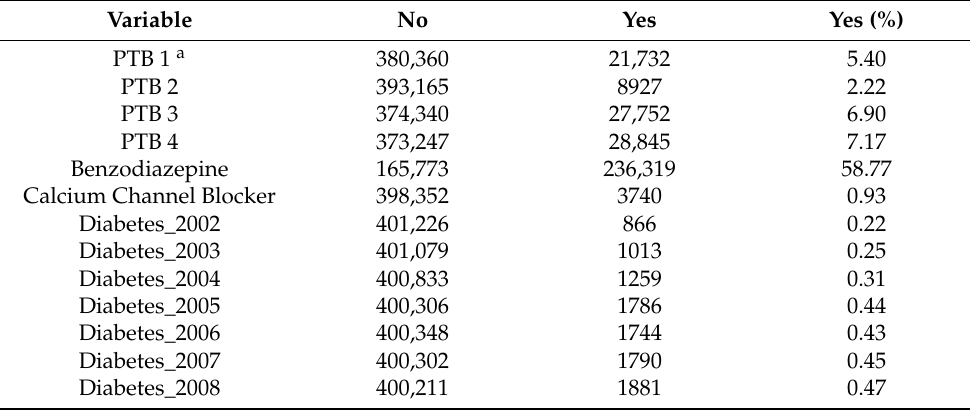
Table 1. Descriptive statistics on preterm birth and its